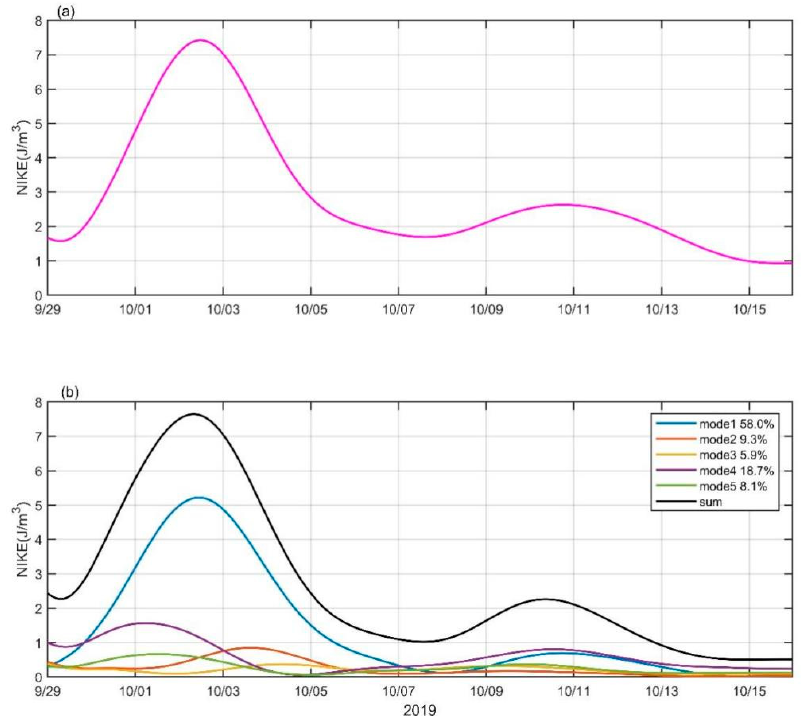
Figure 10. ( a ) Time series of one inertial period low-pass filtered NIKE averaged at depths of 50–300 m at the mooring. ( b ) Same as ( a ) but for modal NIKE, and the black line denotes the combination of these five modes.